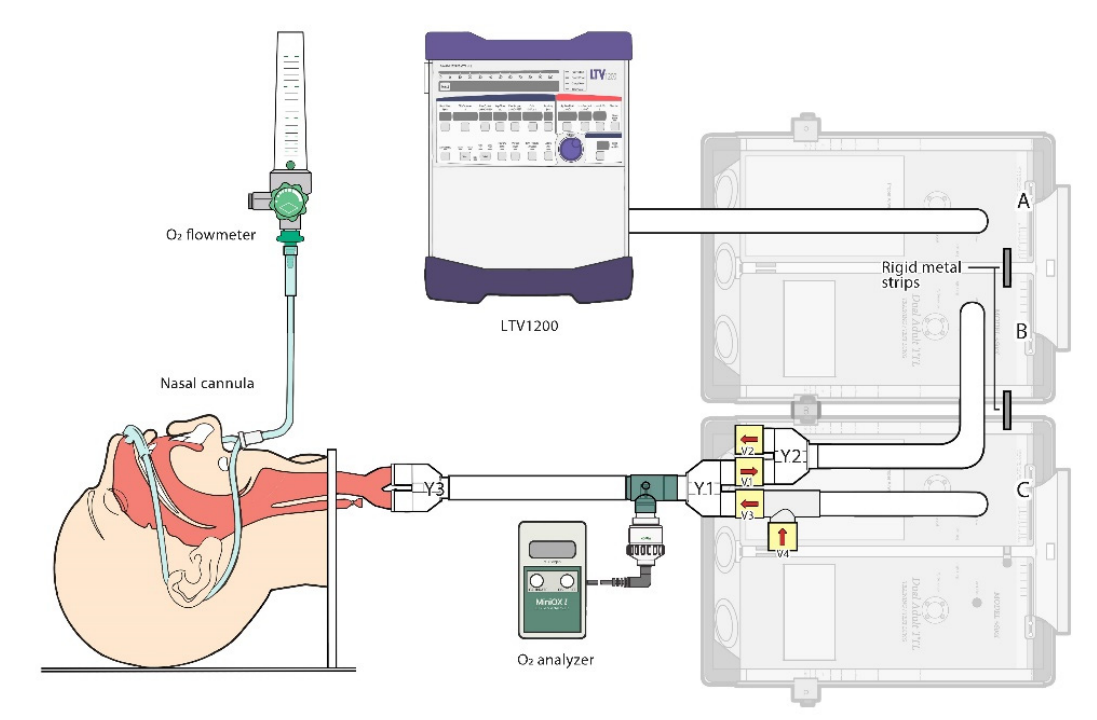
Figure 1. Experimental apparatus of the test lung model. ( A ) driving bellow; ( B ) ventilation bellow; ( C ) expiratory gas modification bellow was constructed.